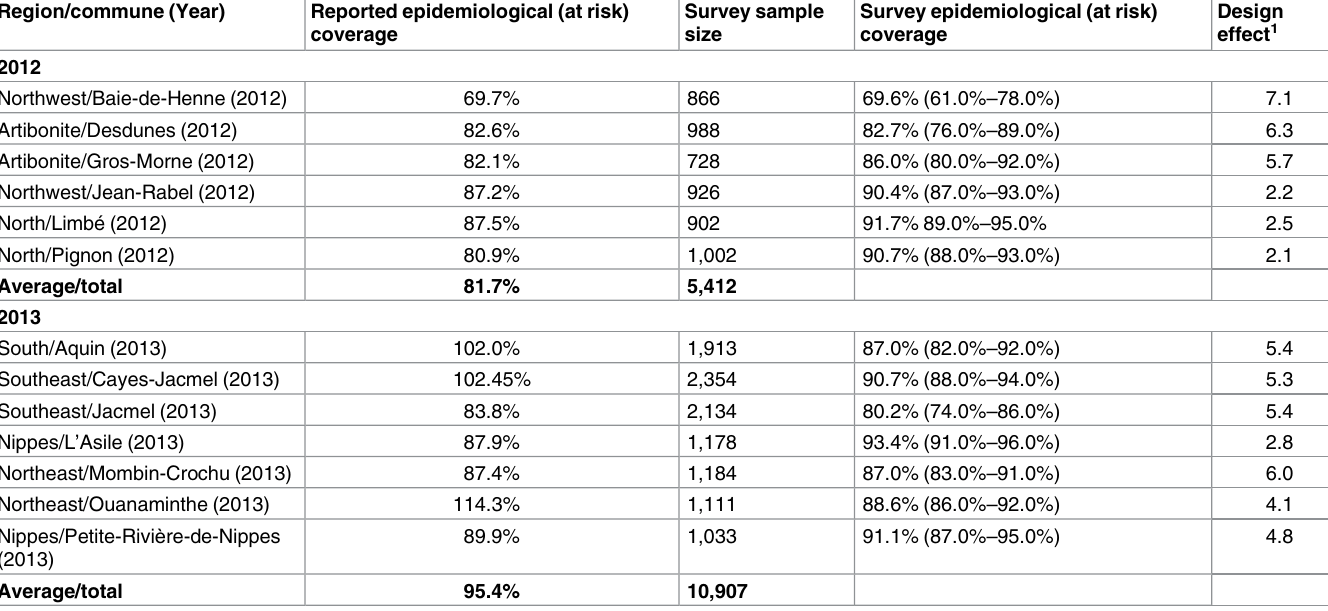
number of communes with coverage below the 65% target ranged from one to five in any given year, with no systematically low-performing communes identified. Post-treatment coverage surveys were used to validate the coverage routinely reported by CDDs. Results of the coverage surveys generally confirmed that coverage rates were at least 65%, and often substantially higher (Table 2). Table 2. Results of surveys conducted in 2012 and 2013 to assesstreatment coveragerates. Region/commune